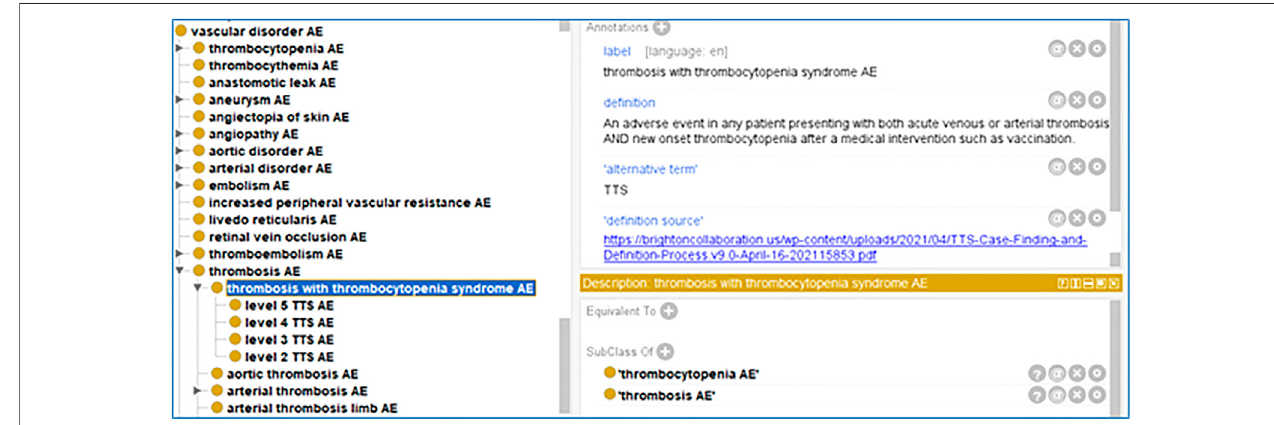
FIGURE 4 | OAE de fi nition of thrombosis with thrombocytopenia syndrome (TTS) AE and its fi ve level subtypes based on Brighton Collaboration case de fi nition (Chen and Black,